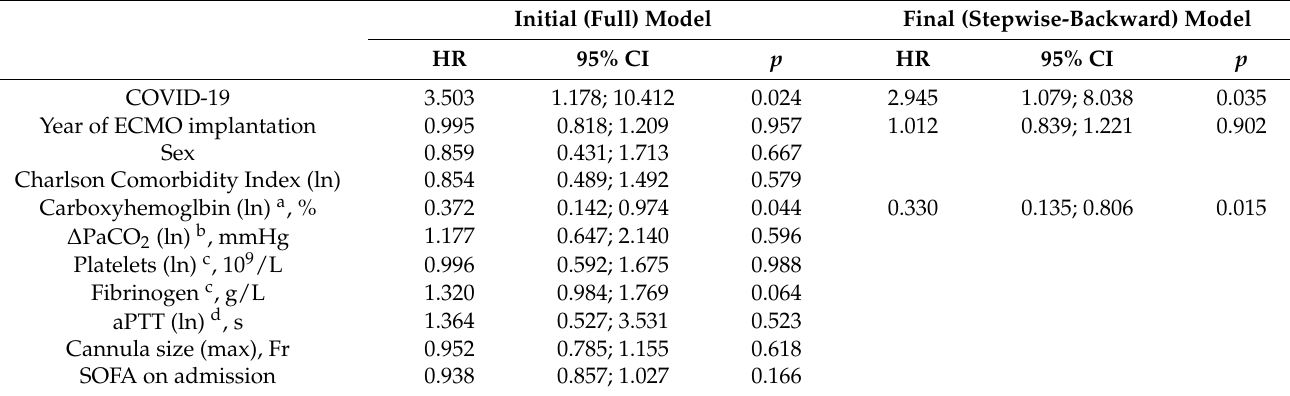
Table 3. Cox regression for association with intracranial